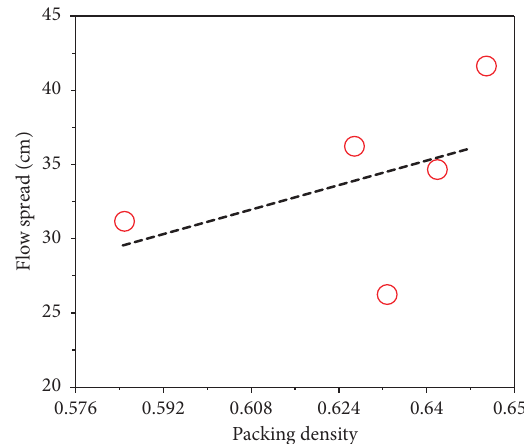
Figure 6: Relationship between packing density and flow